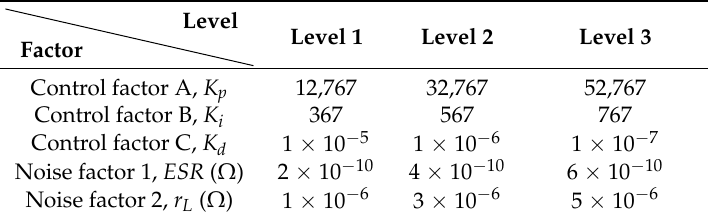
Table 1. Collected cloud data for control factors and corresponding